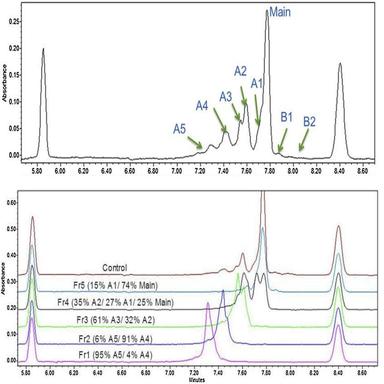
icIEF analysis of fractions collected by FFE. Top panel: The five acidic variant regions identified in the mAb1 starting material icIEF profile. Bottom panel: icIEF profiles of fractions purified by FFE. The control is the starting drug substance purified material. The relative abundance of each region presents in all fractions (Fr1=Fraction 1, Fr2=fraction 2, etc) was determined by icIEF. A5= acidic fraction 5; A4=acidic fraction 4. . ..etc.